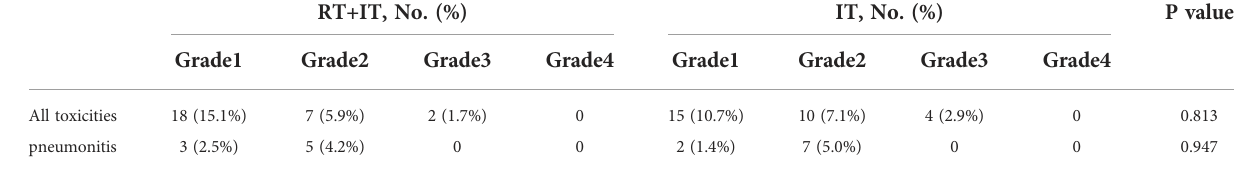
TABLE 3 Adverse